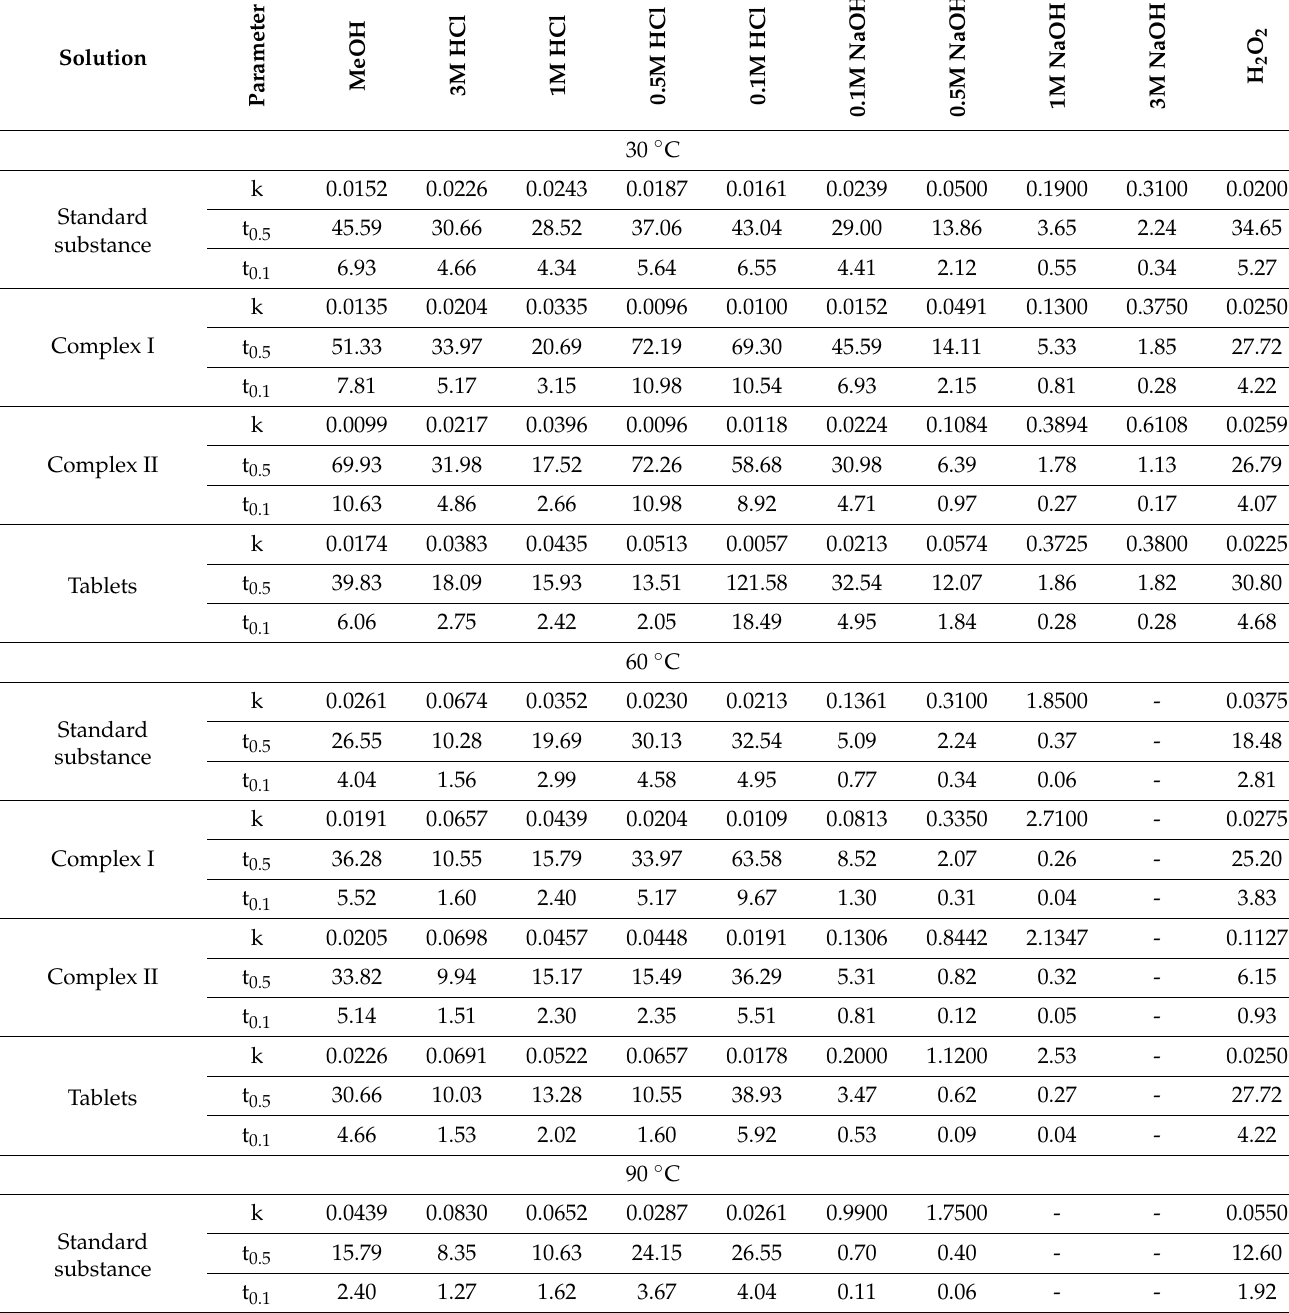
Table 2. Values of kinetic parameters for the MTZ